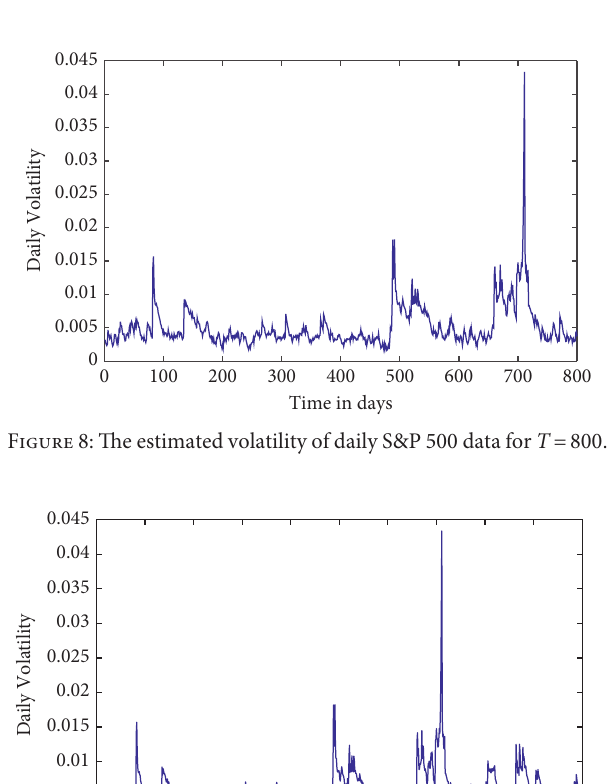
Figure 7: The MSFE obtained by JADE with Archive for S&P 500 data.